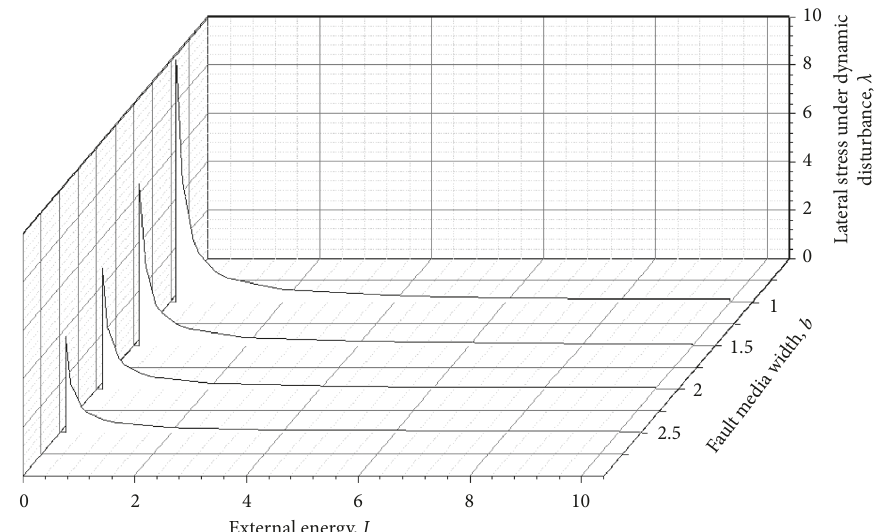
Figure 5: λ − J − b relation